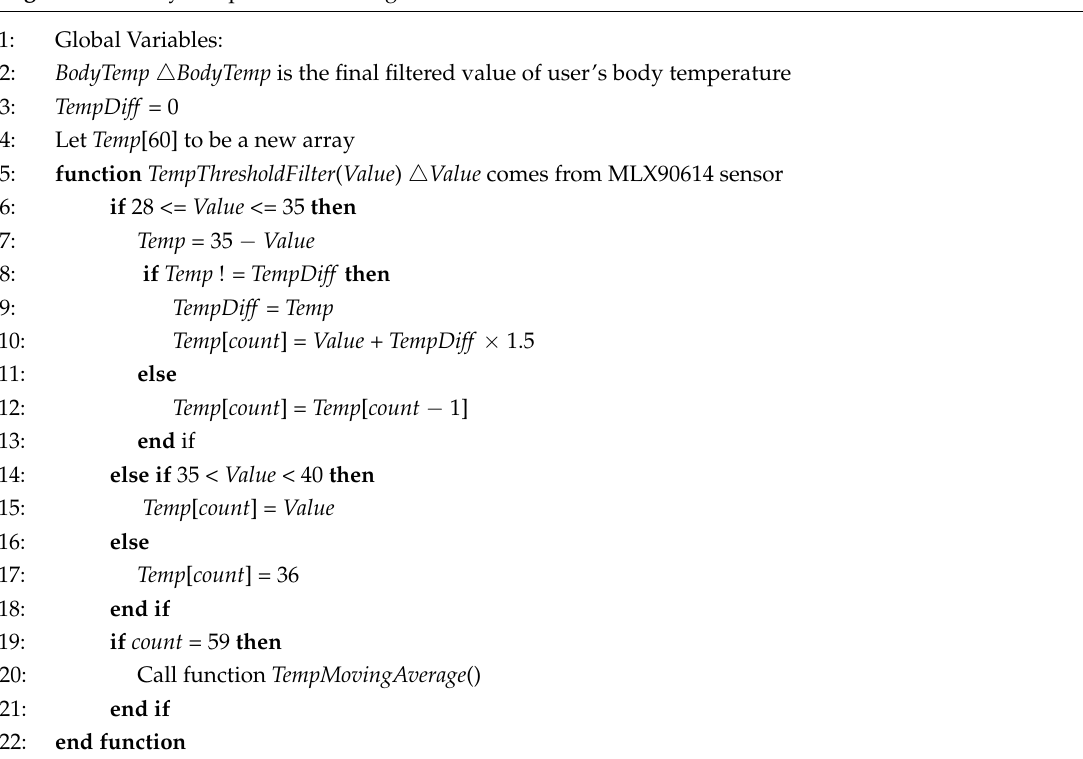
Algorithm 2 Body Temperature